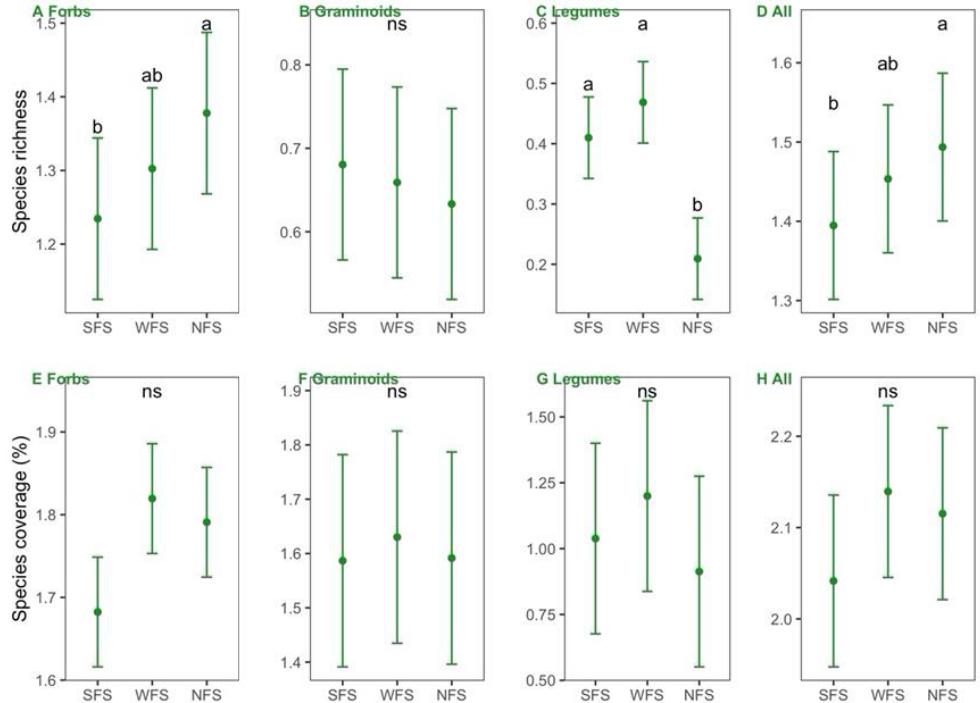
Figure 4. Comparisons of species richness ( A – D ) and coverage ( E – H ) for each plant functional group and the whole community among slope aspects. SFS, WFS, and NFS represent south-, west-, and north-facing slope aspects, respectively. Variables are log10-transformed. The correlations were found to be significantly negative between leaf [N] and rich- ness of all species (R 2 = 0.615, p = 0.047) and forb species (R 2 = 0.570, p = 0.061), between leaf [P] and graminoid richness (R 2 = 0.362, p = 0.093), and between leaf N: P ratios and forb richness (R 2 = 0.675, p = 0.032) (Figure 5). On the other hand, legume coverage was posi- tively correlated with leaf [N] (R 2 = 0.809, p = 0.010), and the coverage of graminoids and all species was negatively and positively correlated with leaf [P] and with marginal sig- nificance and significance, respectively (R 2 = 0.051 and 0.704, p = 0.103 and 0.029, respec- tively) (Figure 6).